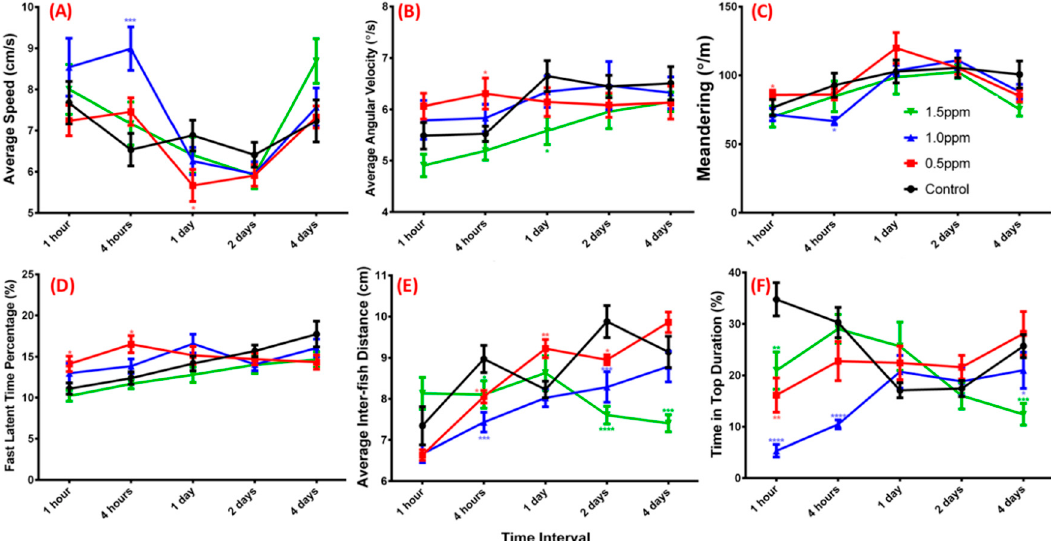
Figure 2. Three-dimensional (3D) locomotor activity assay for ZnCl 2- treated zebrafish. ( A ) Average speed; ( B ) average angular velocity; ( C ) meandering; ( D ) fast latent time; ( E ) total distance traveled by treated and control groups; ( F ) time spent at top of the tank by adult fish within five different time intervals ( n = 18 for each testing concentration). Black line, control; red line, 0.5 ppm ZnCl 2 exposure; blue line, 1.0 ppm ZnCl 2 exposure; green line, 1.5 ppm ZnCl 2 exposure . Locomotor activity was compared to control at each time point using a t -test (* p ≤ 0.05; ** p ≤ 0.01; *** p ≤ 0.001; **** p ≤ 0.0001).